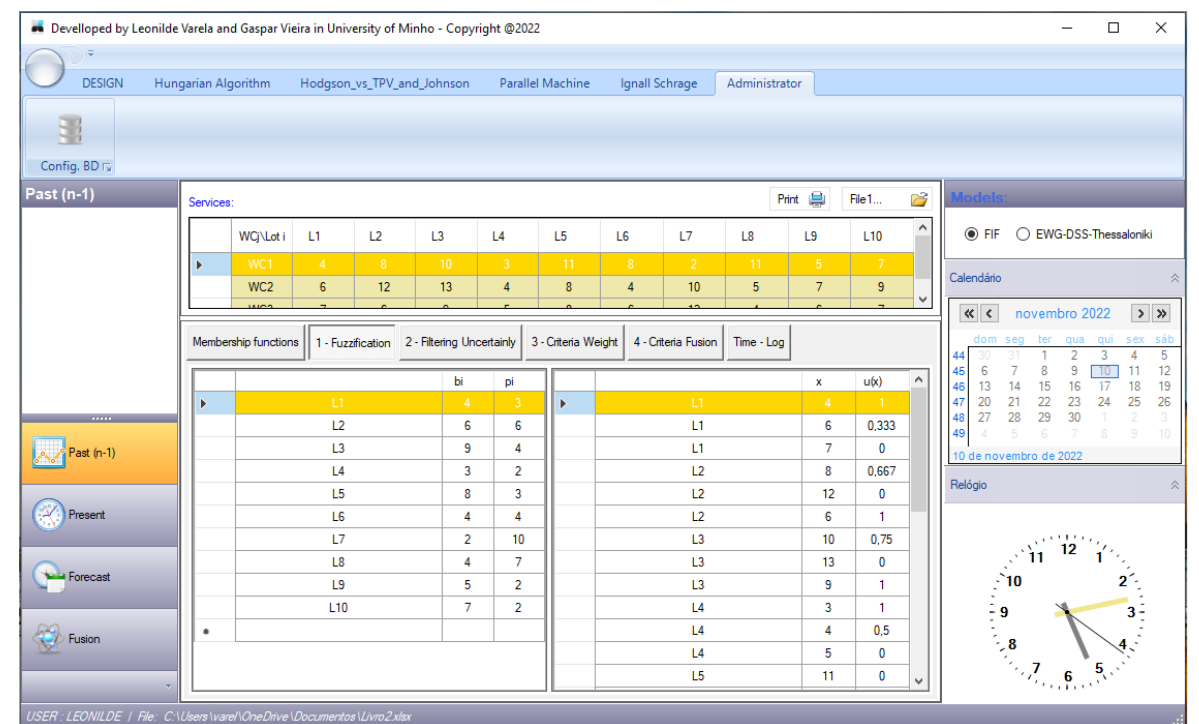
Figure 3. Scheduling framework.